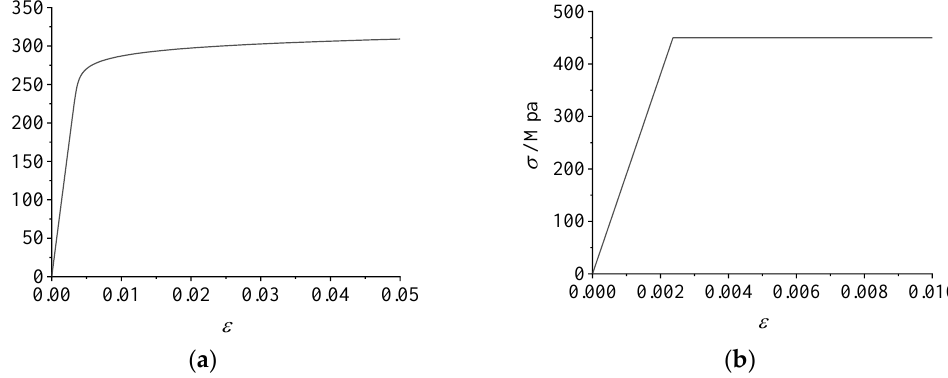
Figure 8. Constitutive models of aluminum alloy and stainless steel. ( a ) The constitutive model of aluminum alloy 6061-T6; ( b ) the ideal elastic-plastic model of stainless steel A2-70.